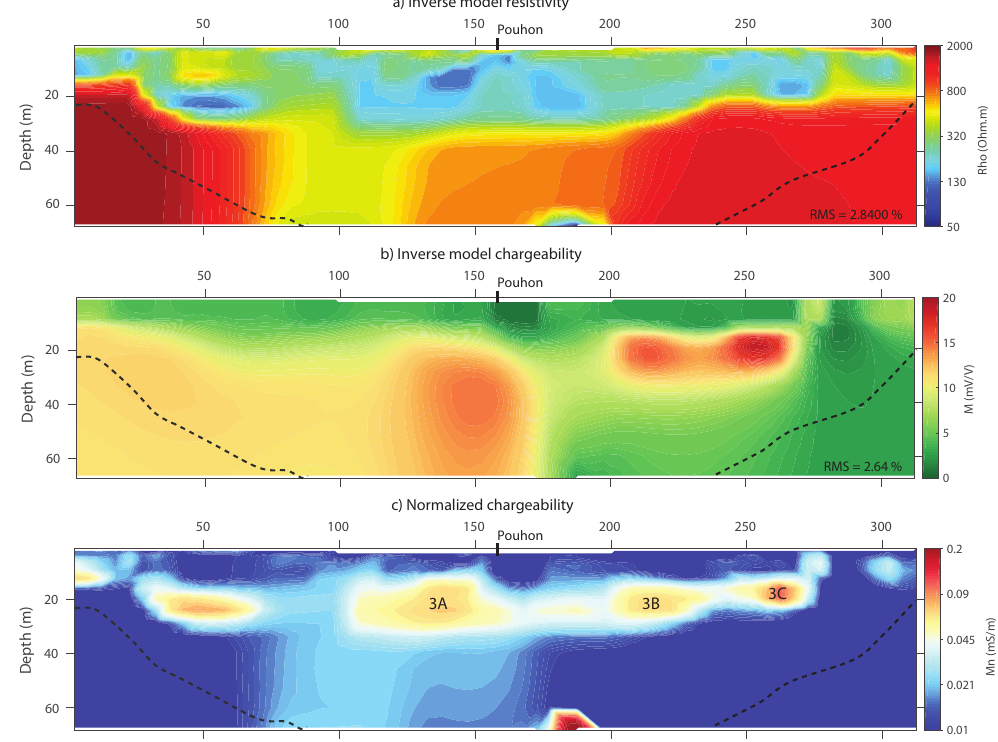
Figure 10. Resistivity, chargeability and normalized chargeability distributions in Profile 3. The location of the pouhon is indicated. Horizontal positions are given in m . The dashed black line indicates the limit below which the DOI value exceeds the trust threshold value of 0.2. The 3 main normalized chargeability anomalies are numbered 3A, 3B and